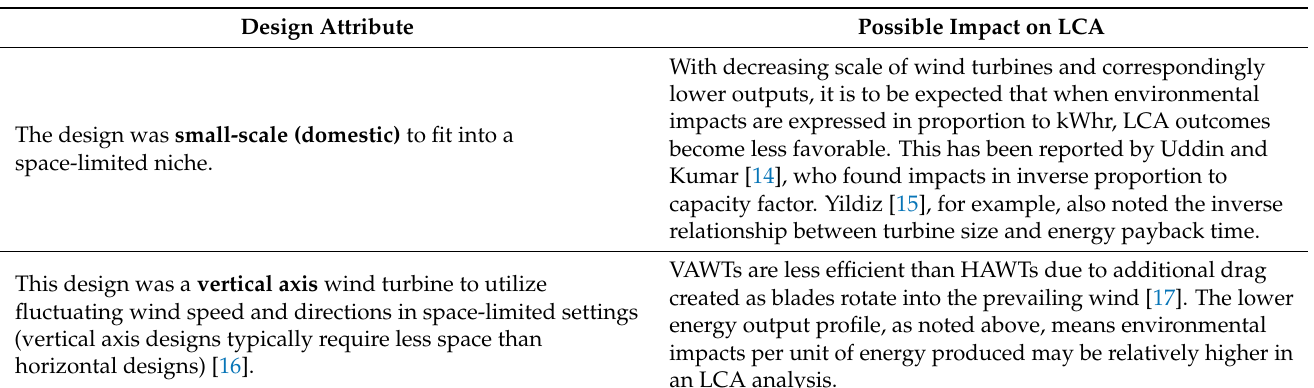
Table 1. VAWT tree design attributes and potential LCA